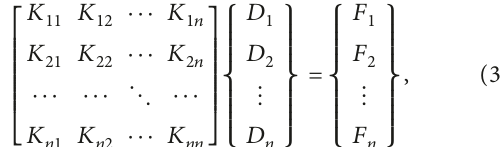
Figure 1: Model of the sliding block along the